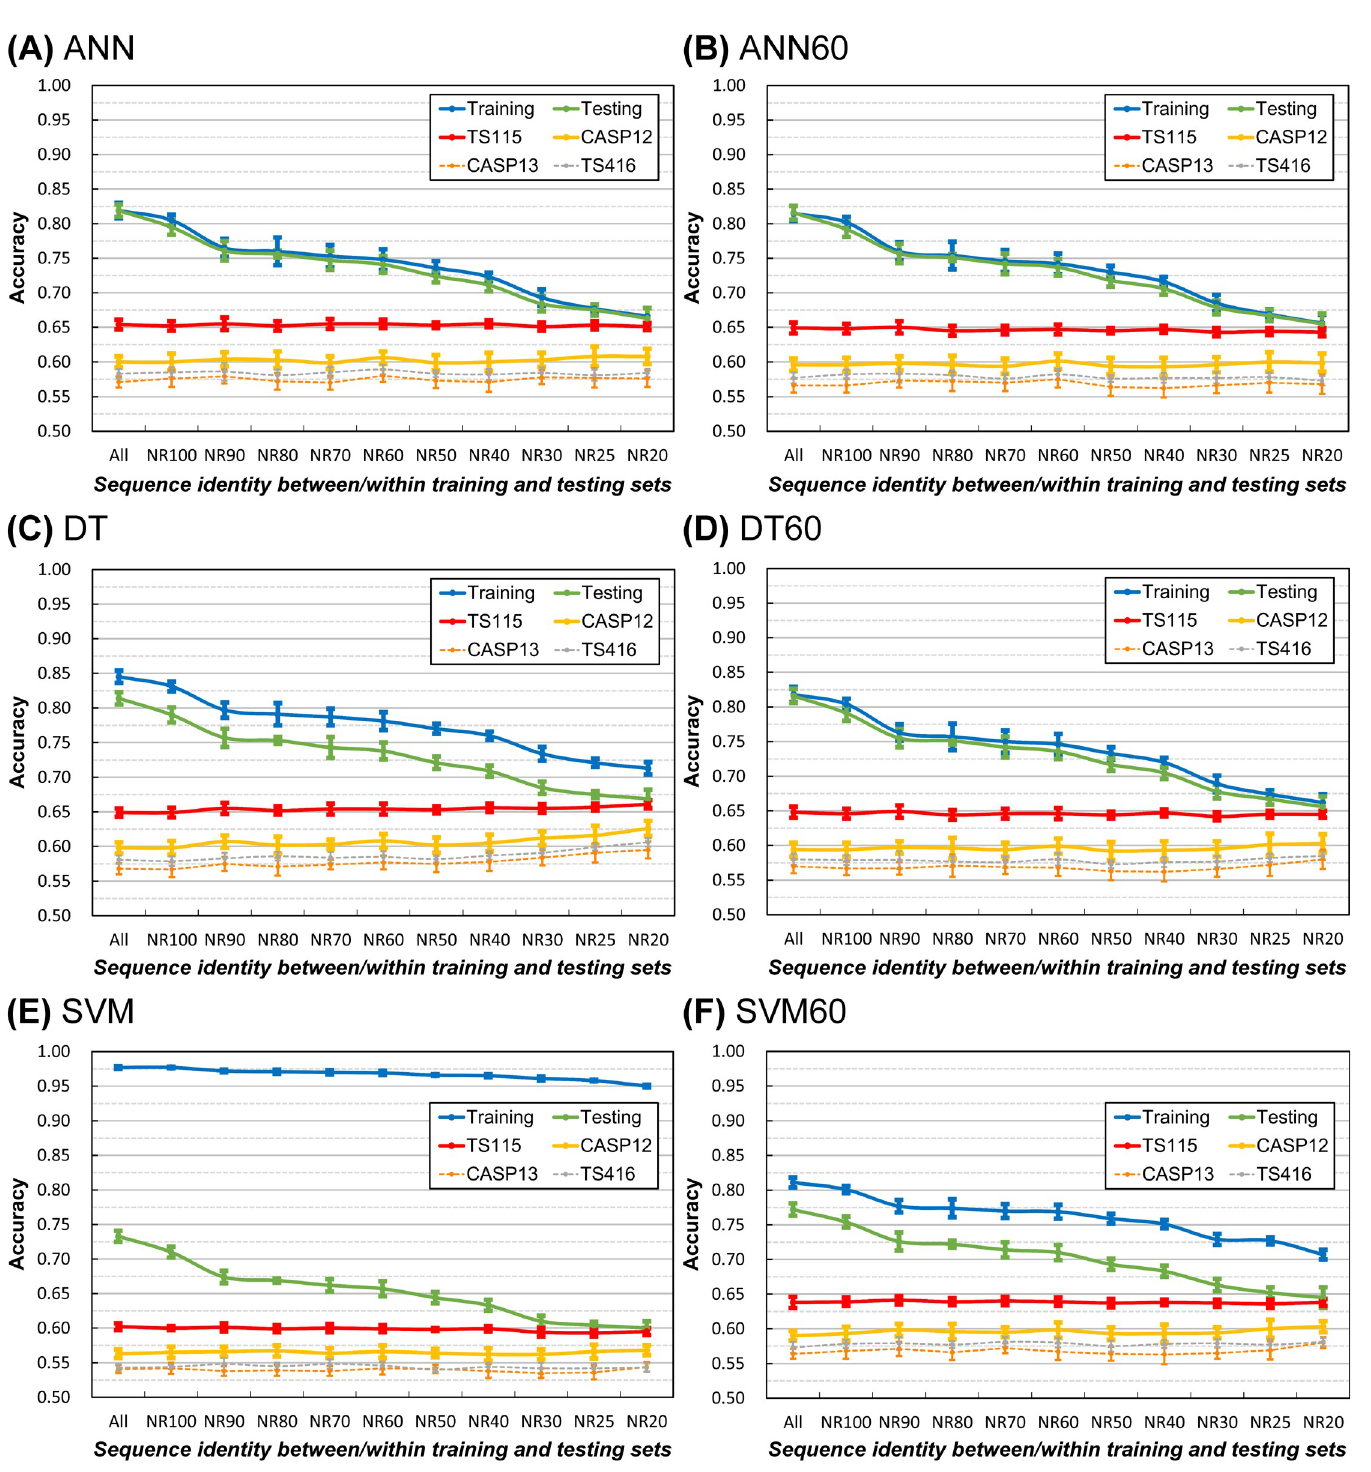
Fig 11. The SSP accuracy of machine learning algorithms obtained with training and testing datasets sharing decreasing levels of sequence homology. (A) Artificial neural network. (B) Random forest of 60 artificial neural networks. (C) Decision tree. (D) Random forest of 60 decision trees. (E) Support vector machine. (F) Random forest of 60 support vector machines. By applying bootstrapping, random forests of different machine learning models were established. The data and feature sets were first randomly sampled into subsets to train small models, which then made the final prediction by vote. Bootstrapping is typically applied with decision trees to form the traditional random forest. The machine learning system utilized in this study [52, 53] can make random forests of algorithms other than the decision tree. The layout of this experiment is shown in Fig 10. At each identity cutoff, the Q3 of training, testing, and independent tests were measured (10 repeats). Among these machine learning algorithms, ANN exhibited the lowest overfitting. SOV was also computed (S11 Fig), and its trends were similar to the trends of Q3 shown here.